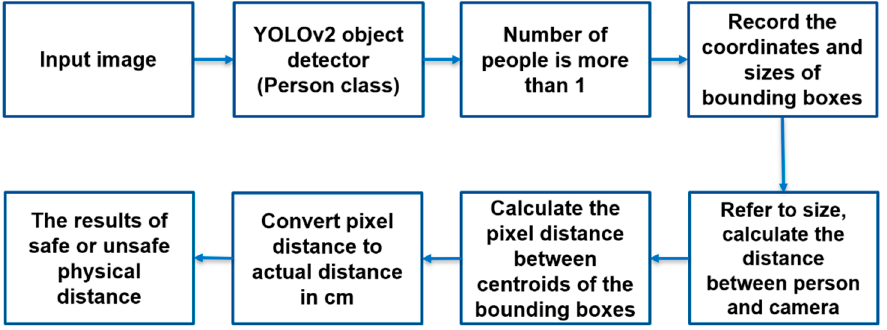
Figure 4. Physical distancing flow chart.